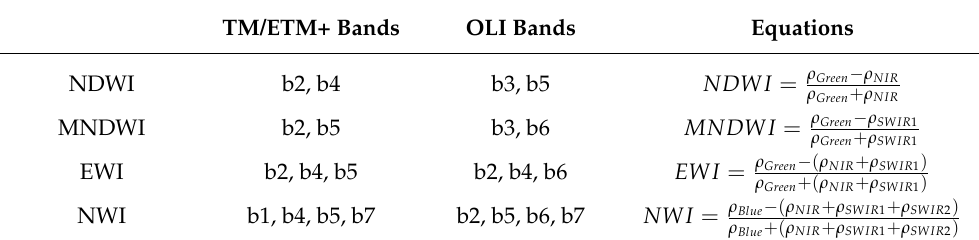
ρ Green : the reflectance of the green band; ρ blue : the reflectance of the blue band; ρ NIR : the reflectance of the near-infrared radiation; ρ SWIR 1 and ρ SWIR 2 : the reflectance of the blue band short wavelength infrared radiation.